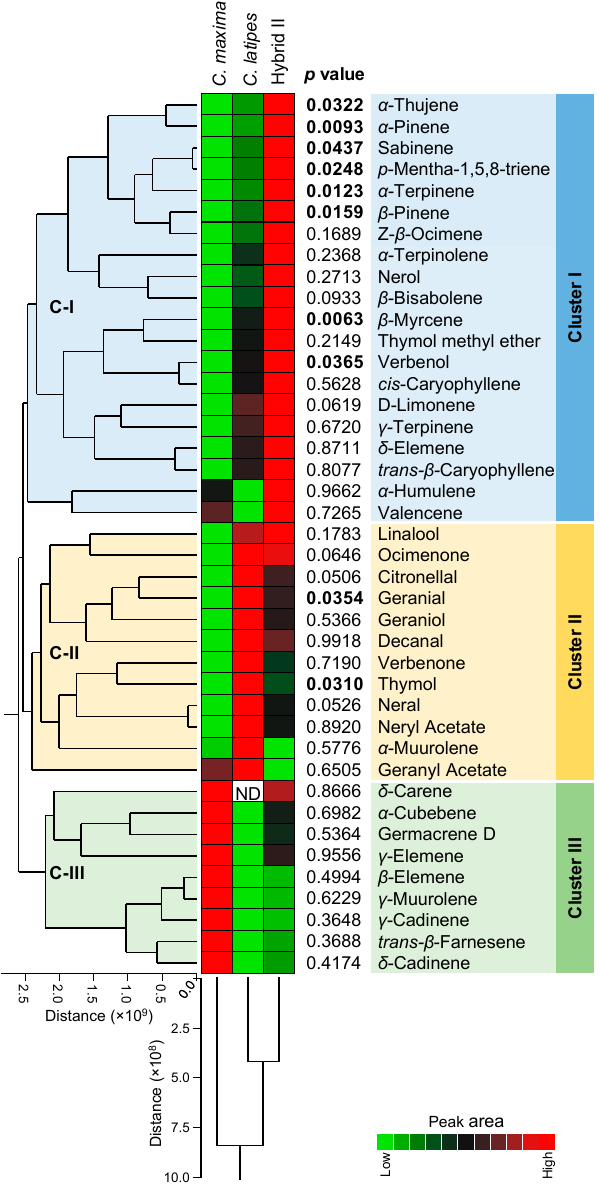
Figure 5. Two-way hierarchical cluster analysis (HCA) and heat map of individual volatile organic compounds released from C. maxima, C. latipes and their promising sexual hybrid (Hybrid II). The differences in the abundances of volatile organic compounds between the three treatments are visualized in the heat map diagram. Rows represent the individual compounds, while columns represent the cultivars and the hybrid. Peak areas were obtained by in vivo SPME-GC-MS. Higher peak areas are colored red and lower peak areas are colored green (see the scale at the right corner of the bottom of the heat map). Volatile organic compounds and treatments were organized using HCA based on Ward’s minimum variance method. The p -values are listed to the right side of the heat map. The bolded p -values indicate statistically significant differences among treatments, while the normal (non-bolded) p -values signify no significant differences among treatments using Tukey–Kramer honest significant difference test (Tukey HSD; p < 0.05), except for the δ -carene, which was analyzed using the two-way t -test ( p < 0.05).